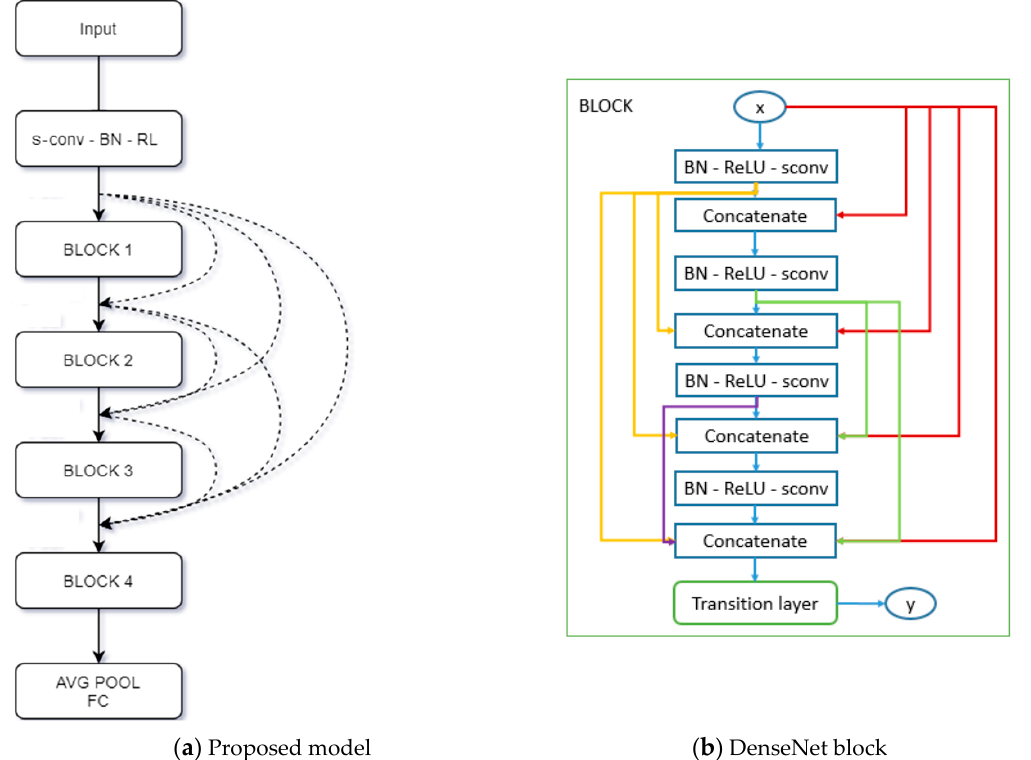
Figure 3. An overview of model architecture. Note that the skip connections are created between blocks (layers with different shapes). Our model can be considered as a larger version of connection of DenseNet with separable convolution instead of normal 2D convolution. Table 1. MDenseNet’s